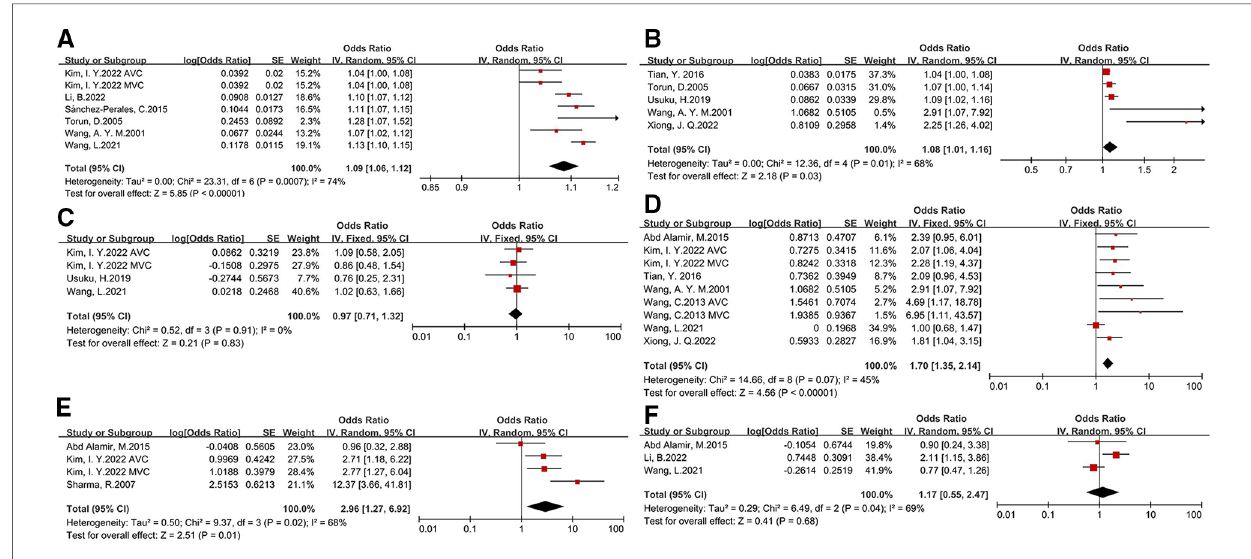
FIGURE 2 Basic characteristics and comorbidity risk factors for development of CVC in CKD patients [( A ) age, ( B) duration of dialysis, ( C ) male sex, ( D ) diabetes, ( E ) coronary heart disease, ( F ) hypertension].